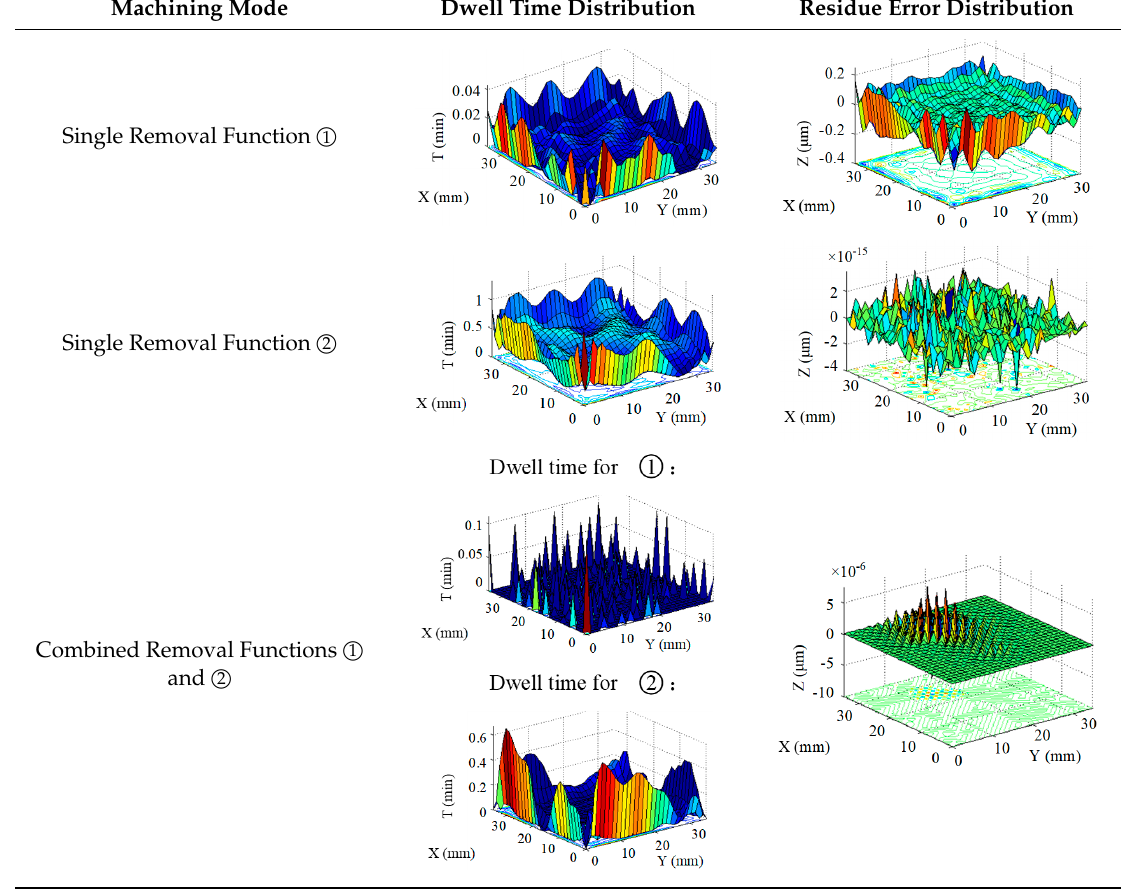
Table 4. Characterization of dwell time and residue error.